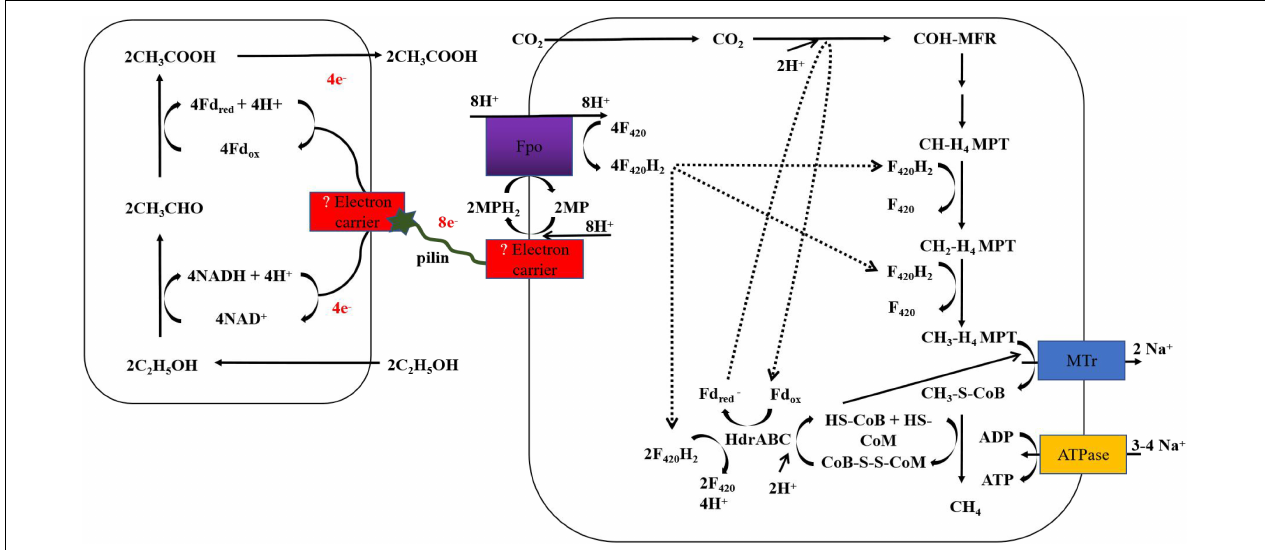
FIGURE 3 | DIET model in co-culture of G. metallireducens and M. barkeri. This figure is adapted from previous paper (Rotaru et al., 2014a; Holmes et al., 2018).